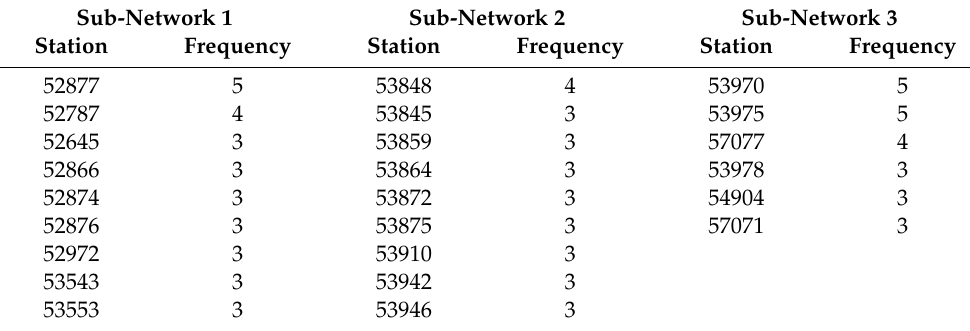
Figure 7. Partitioning of the P-network obtained from the clustering coefficient. Table 3. Important vertices in subnetworks.